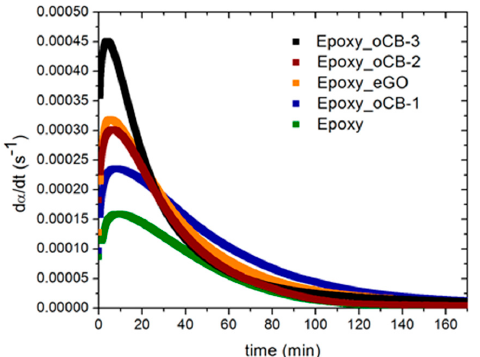
Figure 7. Comparison between d α / d t experimental curves of each system: epoxy resin filled by 3 wt % of different nanofillers: oCB-1 (O/C, wt/wt = 0.16) ( blue ); oCB-2 (O/C, wt/wt = 0.83) ( wine ); oCB-3 (O/C, wt/wt = 0.91) ( black ); eGO (O/C, wt/wt = 0.62) ( orange ).